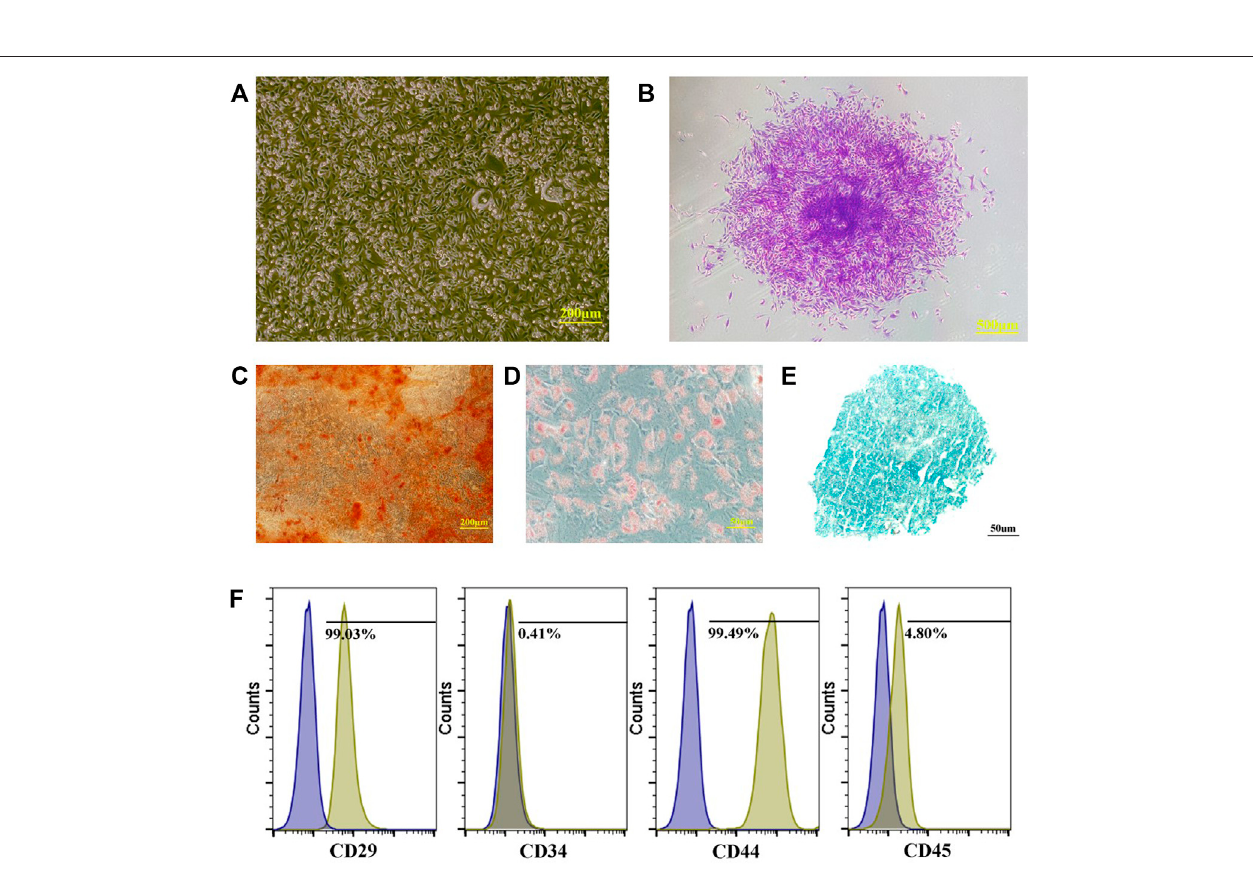
FIGURE 2 | Preparation and identi fi cation of PBMSCs. (A) primary cells of PBMSCs; (B) apparent colonies stained with crystal violet; (C) PBMSCs stained with alizarin red after osteogenic induction; (D) PBMSCs stained with oil red O after adipogenic induction; (E) PBMSCs stained with alician blue after chondrogenic induction and (F) immunophenotypic characterization of